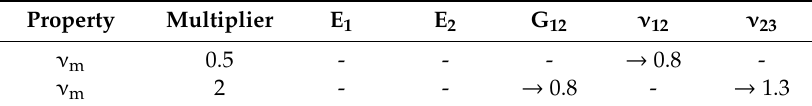
Table 4. Summary of simulated and measured composite properties.